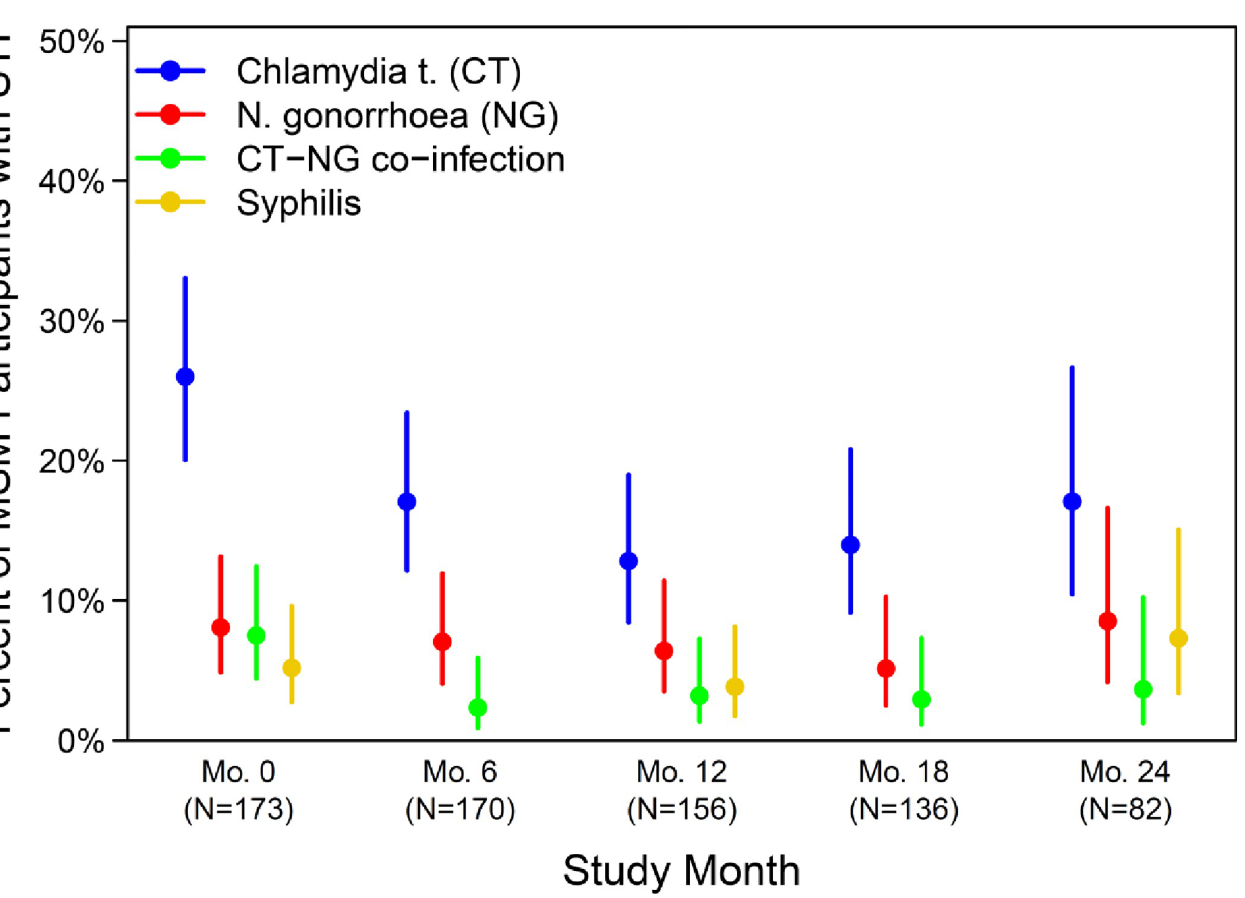
Fig 1. Estimated STI prevalence and 95% Cis over time among MSMs with STI testing data available in HVTN 702.